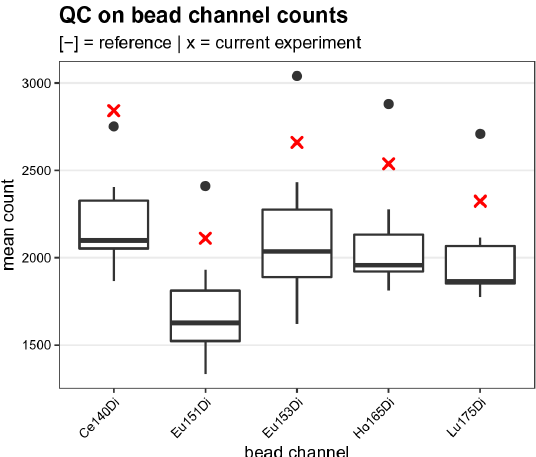
Figure 4. Bead channel count quality control. Boxplot comparing the mean dual ion counts (y-axis) across bead channels (x-axis) obtained for the current experiment (red crosses) to those from 7 previously acquired reference experiments